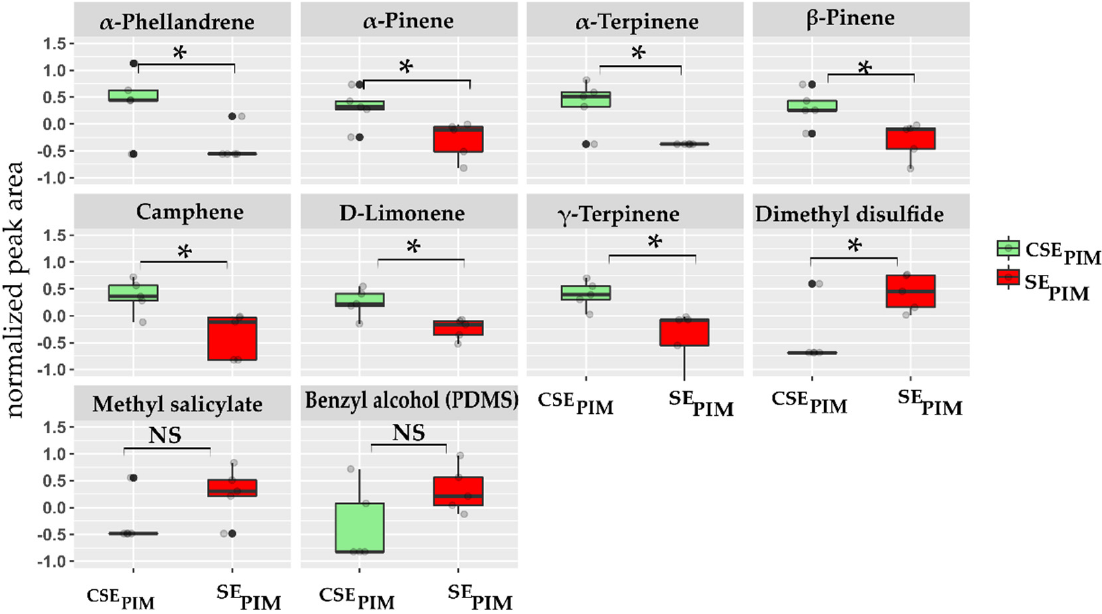
Figure 5. Peak areas of compounds detected by HiSorb in control CSE PIM (green) and herbivory- stressed SE PIM (red) S. pimpinellifolium roots. Each box-plot depicts the distribution and median (horizontal line) of normalized and log10 transformed peak areas of five replicates per treatment. oxplots indicated with an asterisk (*) differ statistically ( p < 0.05), whereas box-plots indicated with NS did not show statistically significant